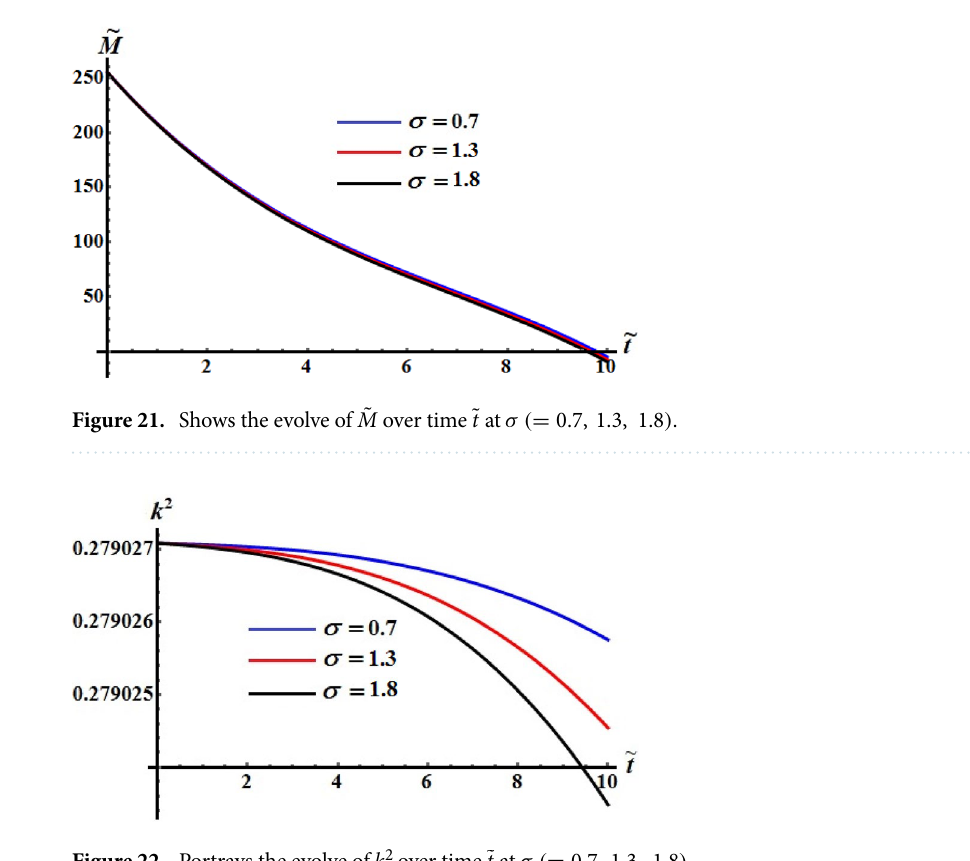
Figure 22. Portrays the evolve of k 2 over time ˜ t at σ ( = 0.7, 1.3, 1.8 )